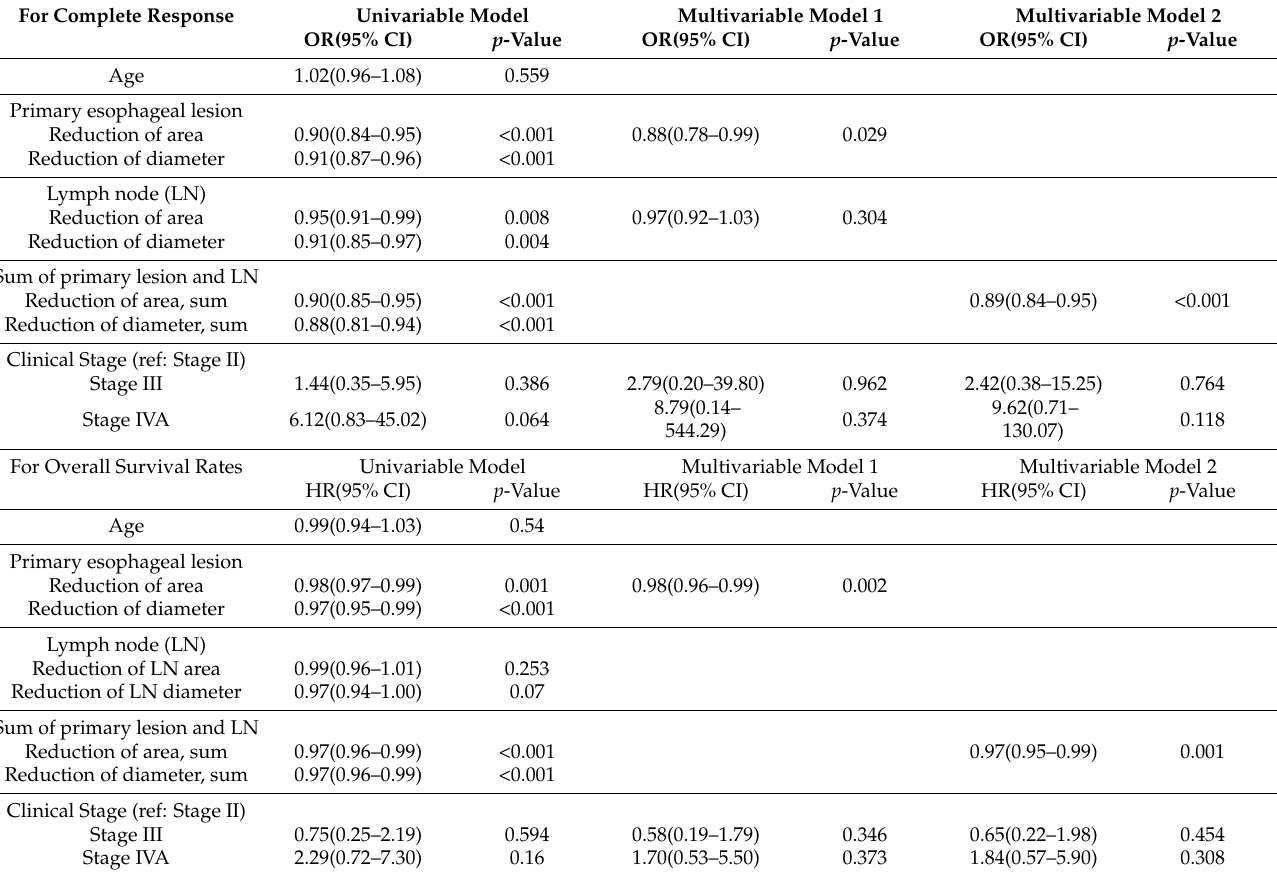
Figure 3. Treatment failure pattern according to the interim response during definitive chemoradiotherapy. The proportion of y-axis refers to the percentage of each treatment failure pattern when the treatment response of the x-axis is higher than that of the x -axis value. When the response to treatment estimate was divided by 5%, the rate of local failure tended to increase by up to 15% and turned to be decreased over 15%. Estimates of the outfield failure rate tended to display a pattern in the opposite direction. Table 4. Multivariate analyses about complete response and overall survival